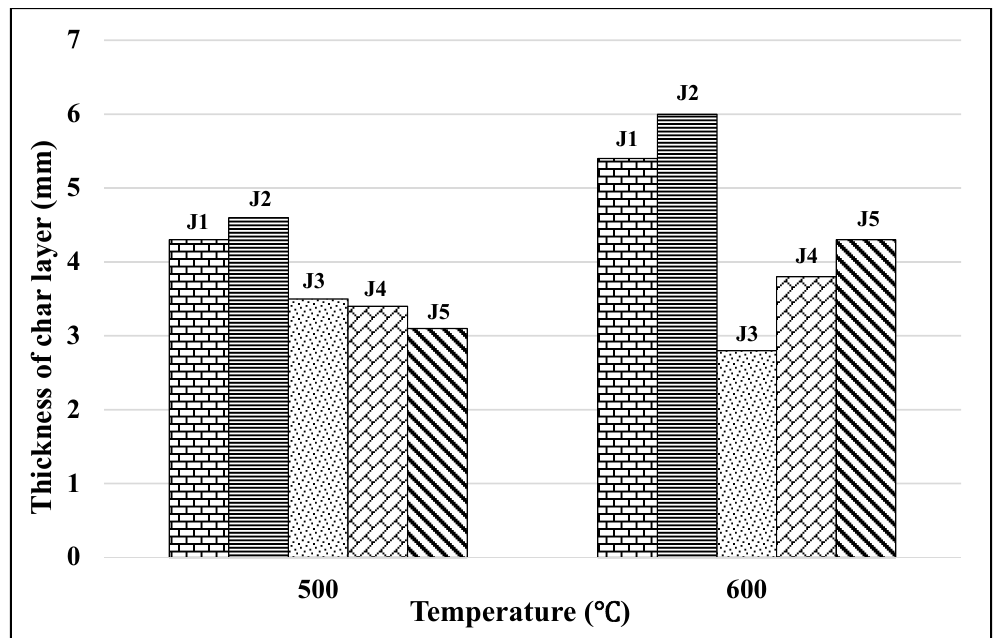
Figure 6. Thickness of char layer of the coated samples at 500 and 600 °C.